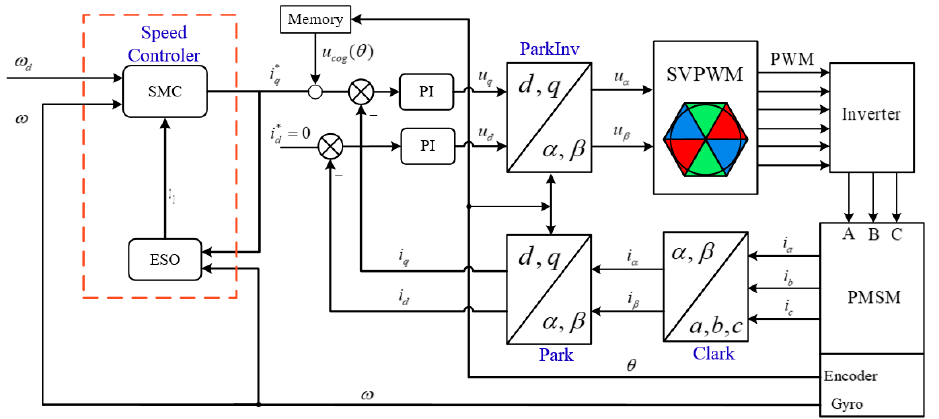
Figure 10. Control block diagram of PMSM based on compound controller.